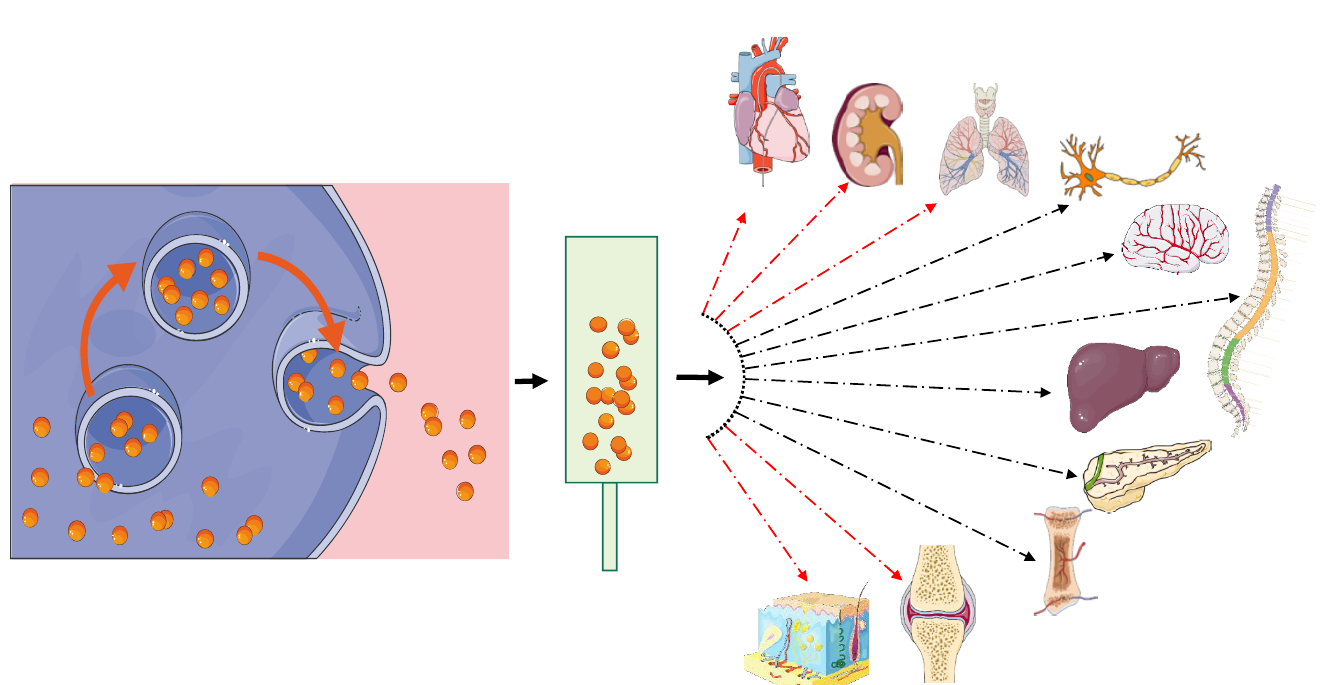
Figure 4. Schematic diagram of overall MSC isolation and their clinical applications in various organs and treatments (literature described in manuscript indicated in red arrows).